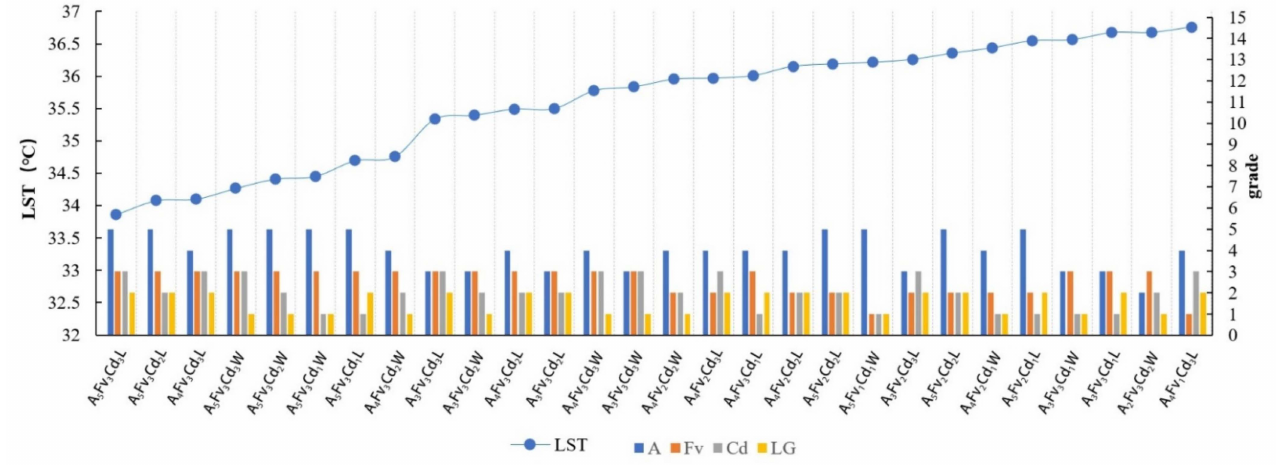
Figure 8. Sorted MG types with LST values lower than 36.8 ◦ C in the Width-I river buffer zone and the linear correlation between the MG types and their LST